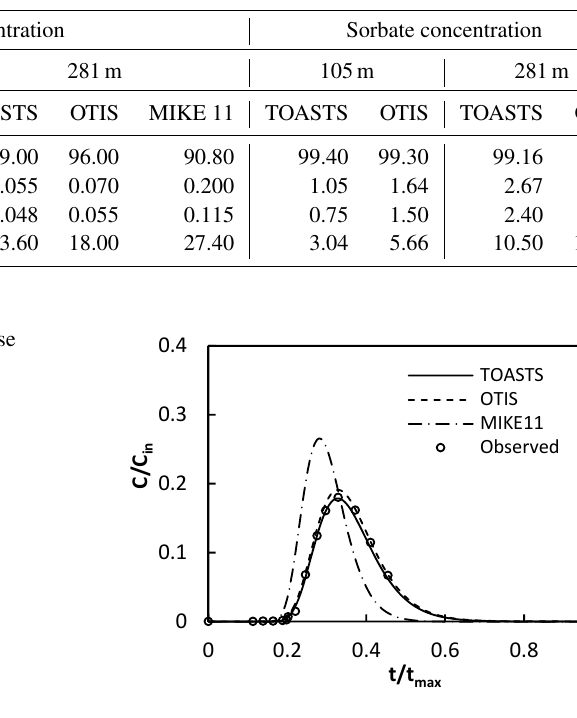
Figure 18. Simulation results for the Athabasca River experiment (test case 5).